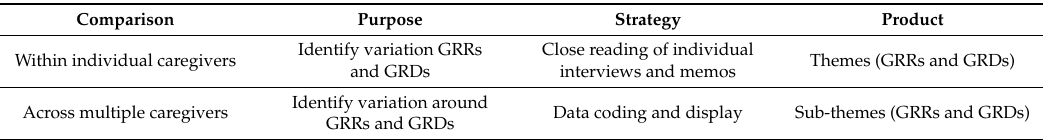
Table 2. An example of the analytical strategy of a within individualized case and a across multiple case analysis used in this study